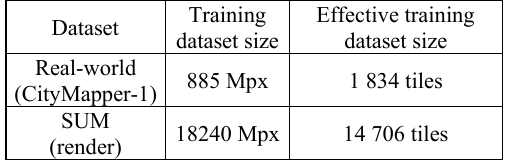
Sizes of the training datasets ( used for semantic segmentation of oblique images) in Mpx and number of tiles ( 624 x 624 px